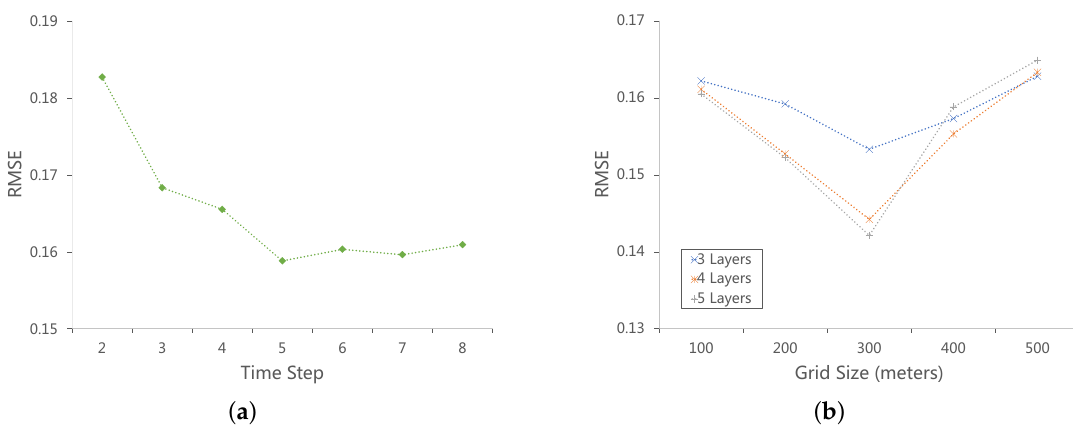
Figure 9. Performance on Parameters with Different Values. ( a ) Performance on different time step values. ( b ) Performance on different grid sizes and different attention layer